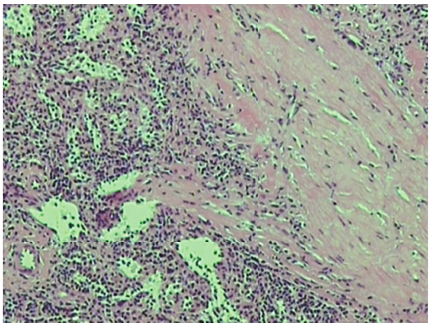
F 3: e red pulp consists of a complex network of venous sinuses and the cords of Billroth. e cords contain most of the splenic macrophages. e sinuses have a discontinuous wall which allows traffic of blood cells between cords and sinuses.